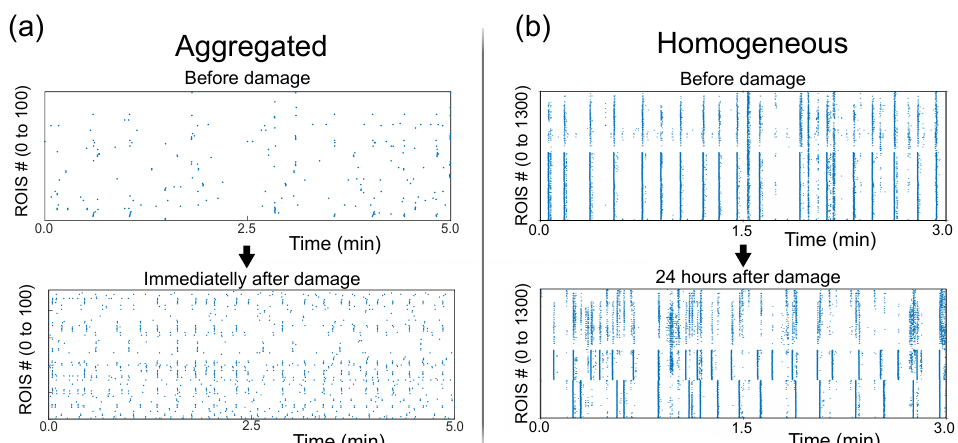
Figure 2. Changes in spontaneous activity upon damage. ( a ) Raster plots of spontaneous activity for an aggregated culture, illustrating the increase in activity immediately after damage. Each blue dot corresponds to the activation of an aggregate. ( b ) Raster plots for homogeneous cultures 24 h after damage, illustrating the rupture of network-wide synchronous activity onto a segregated dynamics within the two halves of the culture. Each dot corresponds to a region of interest